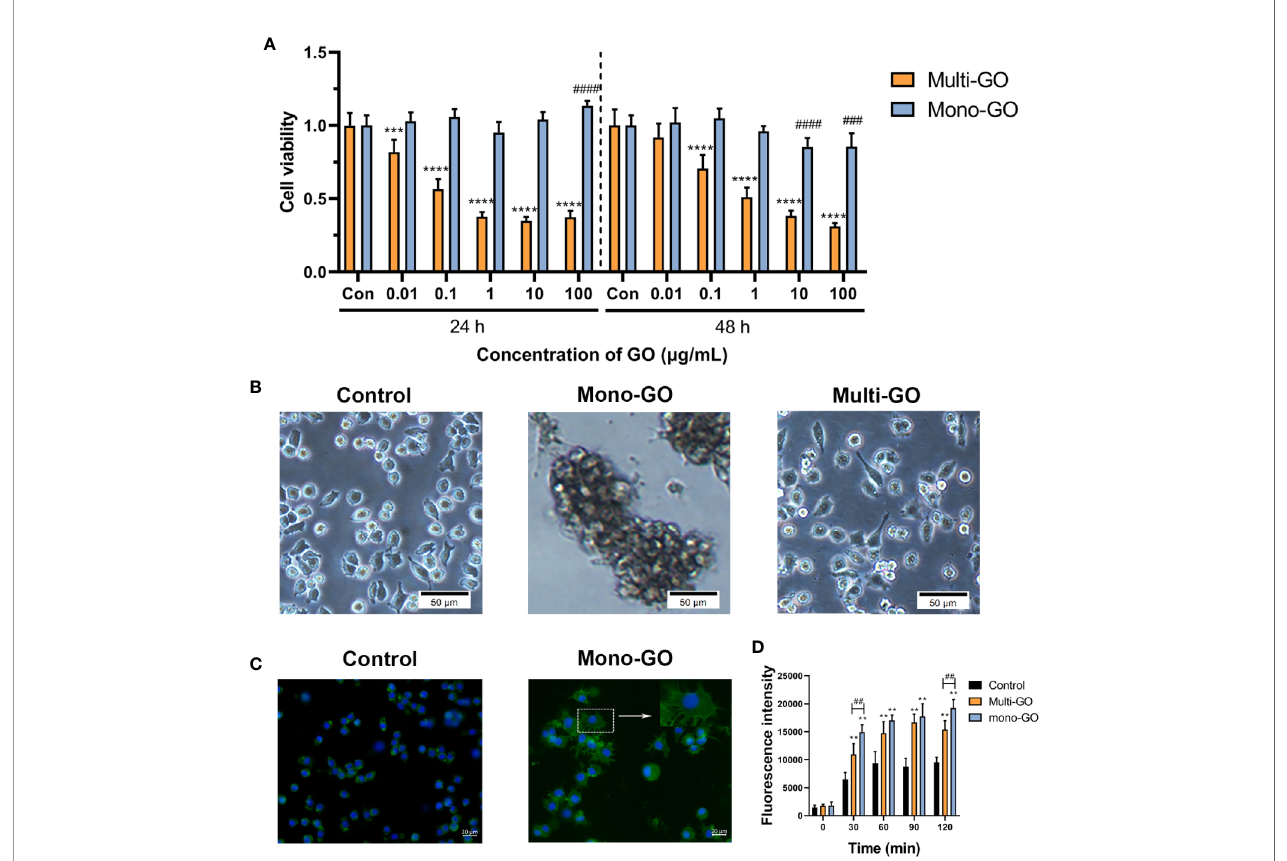
FIGURE 2 | The effect of graphene oxide (GO) on the viability and morphology of DC2.4 cells. (A) The effect of mono-GO and multi-GO on the viability of DC2.4 cells for 24 h and 48 h. n = 10. ***P<0.001, ****P<0.0001 multi-GO vs. Control; ### P<0.001, #### P<0.0001 mono-GO vs. Control. (B) Representative bright fi eld images of DC2.4 cells treated with phosphate-buffered saline (PBS), 10 m g/ml mono-GO, and 10 m g/ml multi-GO. Scale bar = 50 m m. (C) Representative fl uorescent picture of DC2.4 treated with control and mono-GO after phalloidin-FITC staining. Scale bar = 20 m m. (D) The production of reactive oxygen species (ROS) in DC2.4 cells treated with multi-GO and mono-GO within 120 min. (**P < 0.01 vs. Control; ## P < 0.01 vs.